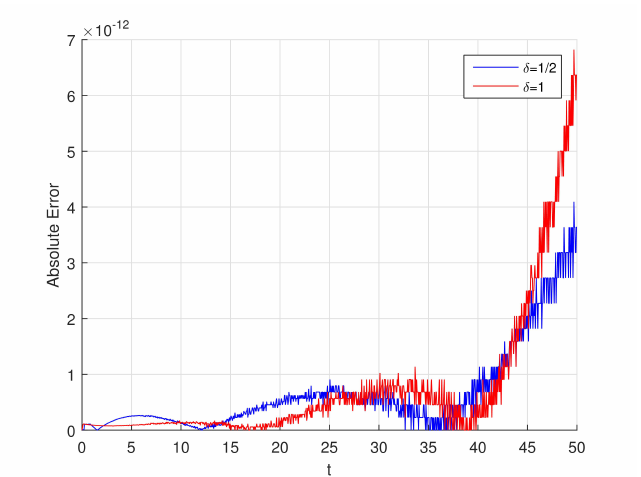
Figure 13. The behaviour of the absolute errors for proposed method where α = 1.5, t ∈ [ 0,50 ] with m = 4 and δ = 1/2,1.